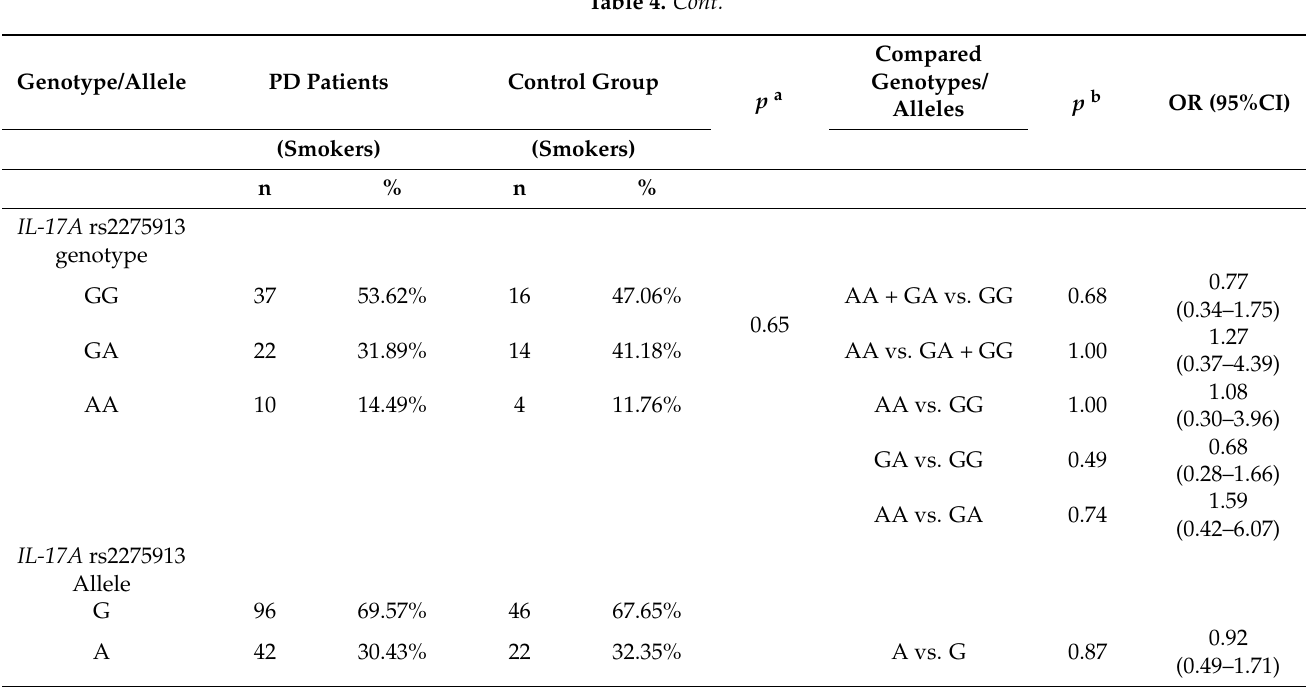
Figure 2. The distribution of IL-17F rs763780 and IL-17A rs2275913 alleles in periodontitis patients and control group in non-smokers group.